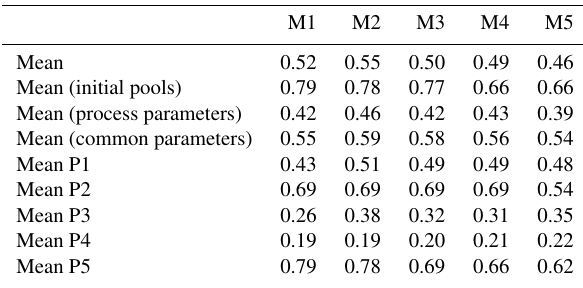
Table A3. Aggregated of information presented in Table A2 of pos- terior parameter constraint for each model. Presented is the Brazil- wide mean of 1 − posterior : prior, indicating the relative reduction in parameter uncertainty for each DALEC model. Each parameter is allocated to one of the following broad parameter definitions: GPP allocation (P1), canopy phenology (P2), other plant turnover (P3), decomposition processes (P4) and initial conditions (P5); see Ta- ble A2 for